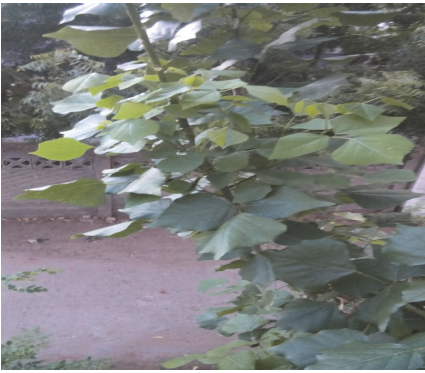
Figure 1: Medicinal plants, Erythrina variegate